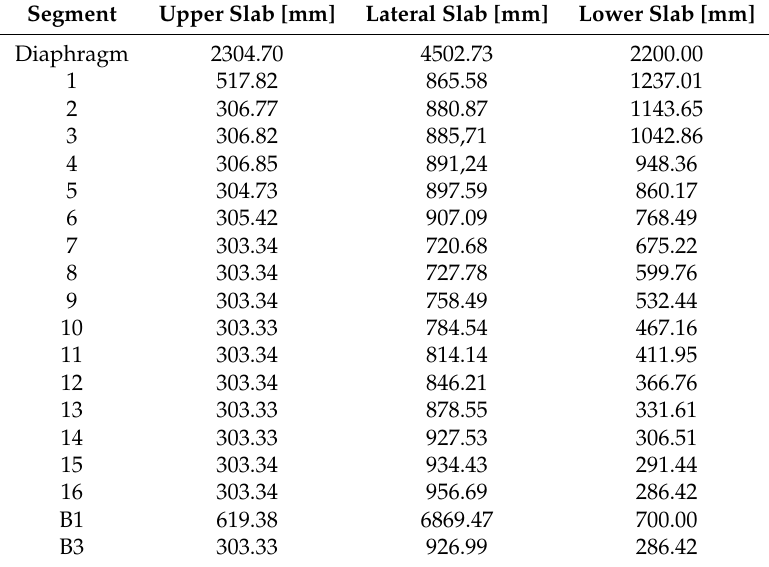
Table 3. Effective thickness, D = 2 V / S , of the different elements in the cross sections.